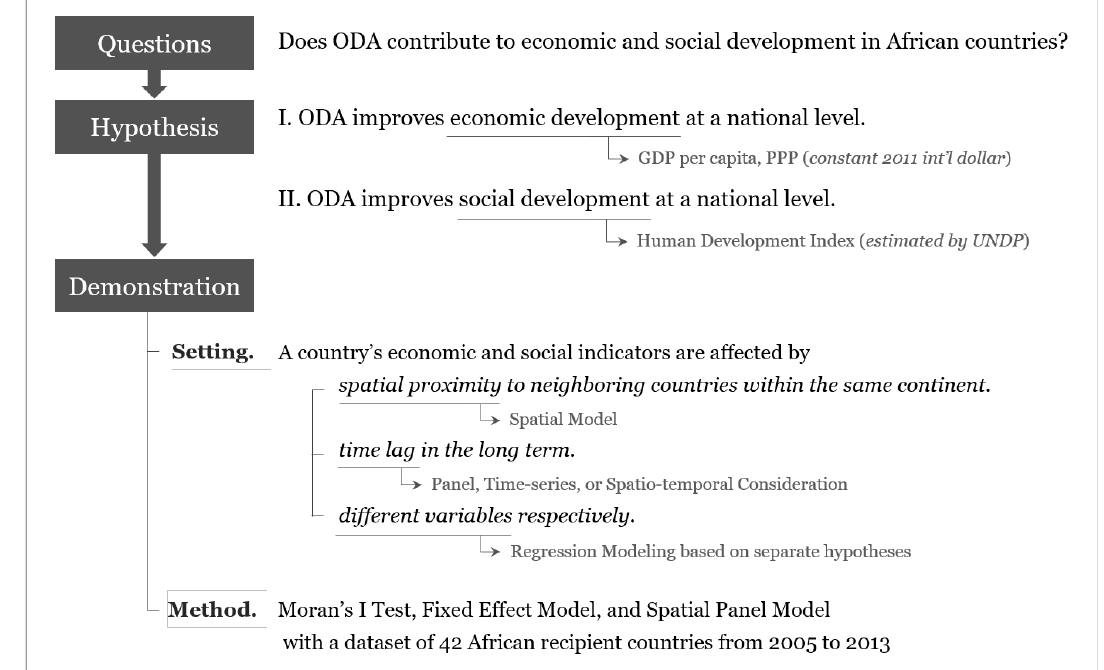
Figure 1. Empirical framework of this study.